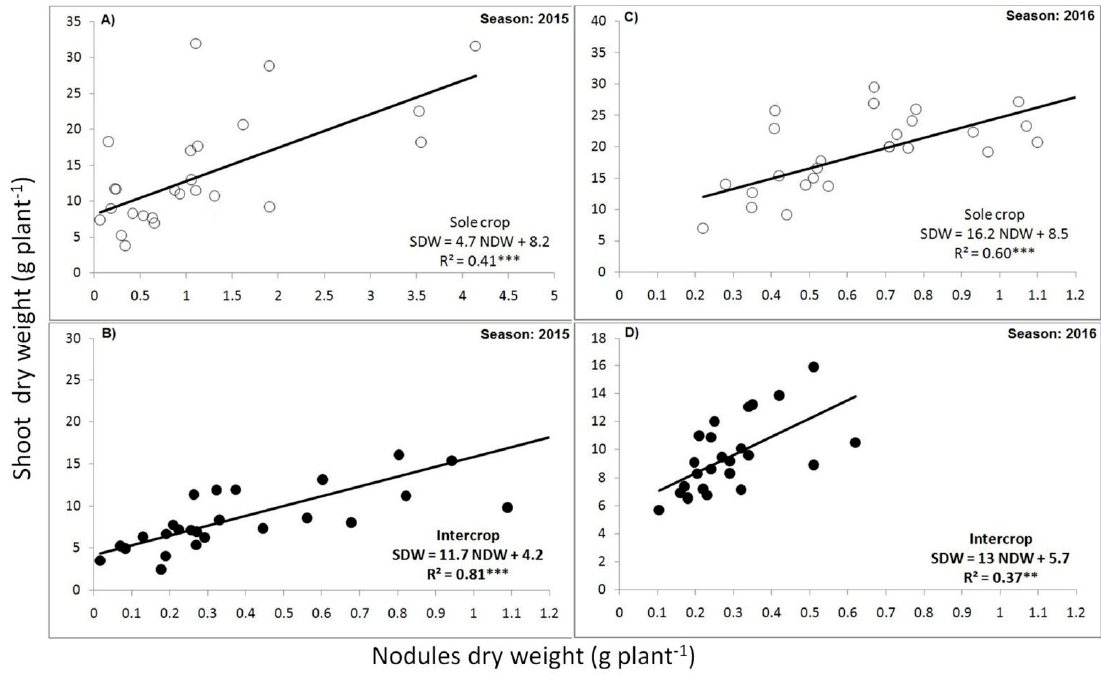
Figure 4. Efficiency in the use of rhizobial symbiosis (EURS) of chickpea as sole crop ( A and C : opened circle) and intercrops ( B and D : filled circle) in 2015 and 2016. The equations inserted in the graphs are the linear regression functions. The slope of each equation represents the estimated value of EURS. All regressions were calculated for 25 plants harvested 120 days after sowing. Asterisks “** and ***” denote significance at p < 0.01 and p < 0.001, respectively.